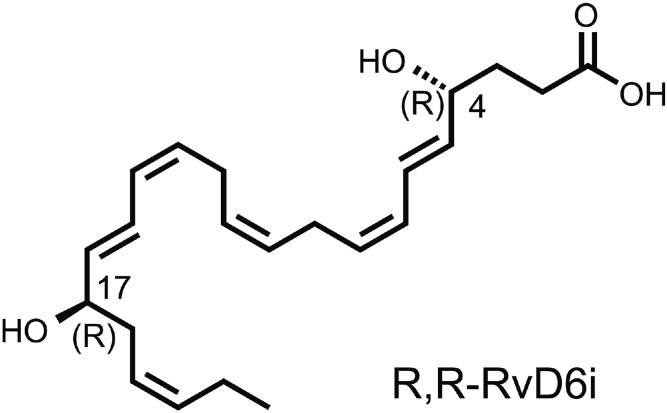
Structure of the RvD6i. The new isomer was synthesized after topical stimulation of mouse injured corneas with PEDF+DHA and released in tears. It was analyzed by LC-MS/MS and showed at least six matched daughter ions with an RvD6 standard but with an earlier retention time (40). Posterior studies show that the peak retention time coincides with chemically synthetized R,R-RvD6i in a chiral column (unpublished observations).